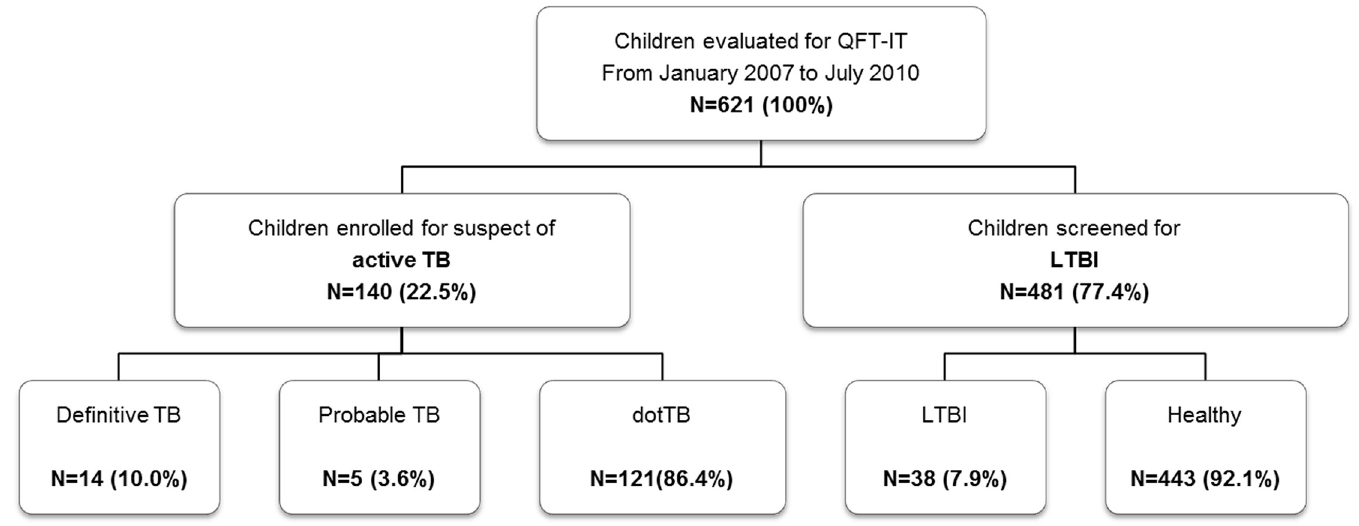
Fig 1. Flow chart of the study. (Abbreviations: TB: tuberculosis; LTBI: latent TB infection; QFT-IT: QUANTIferon TB Gold in tube.)